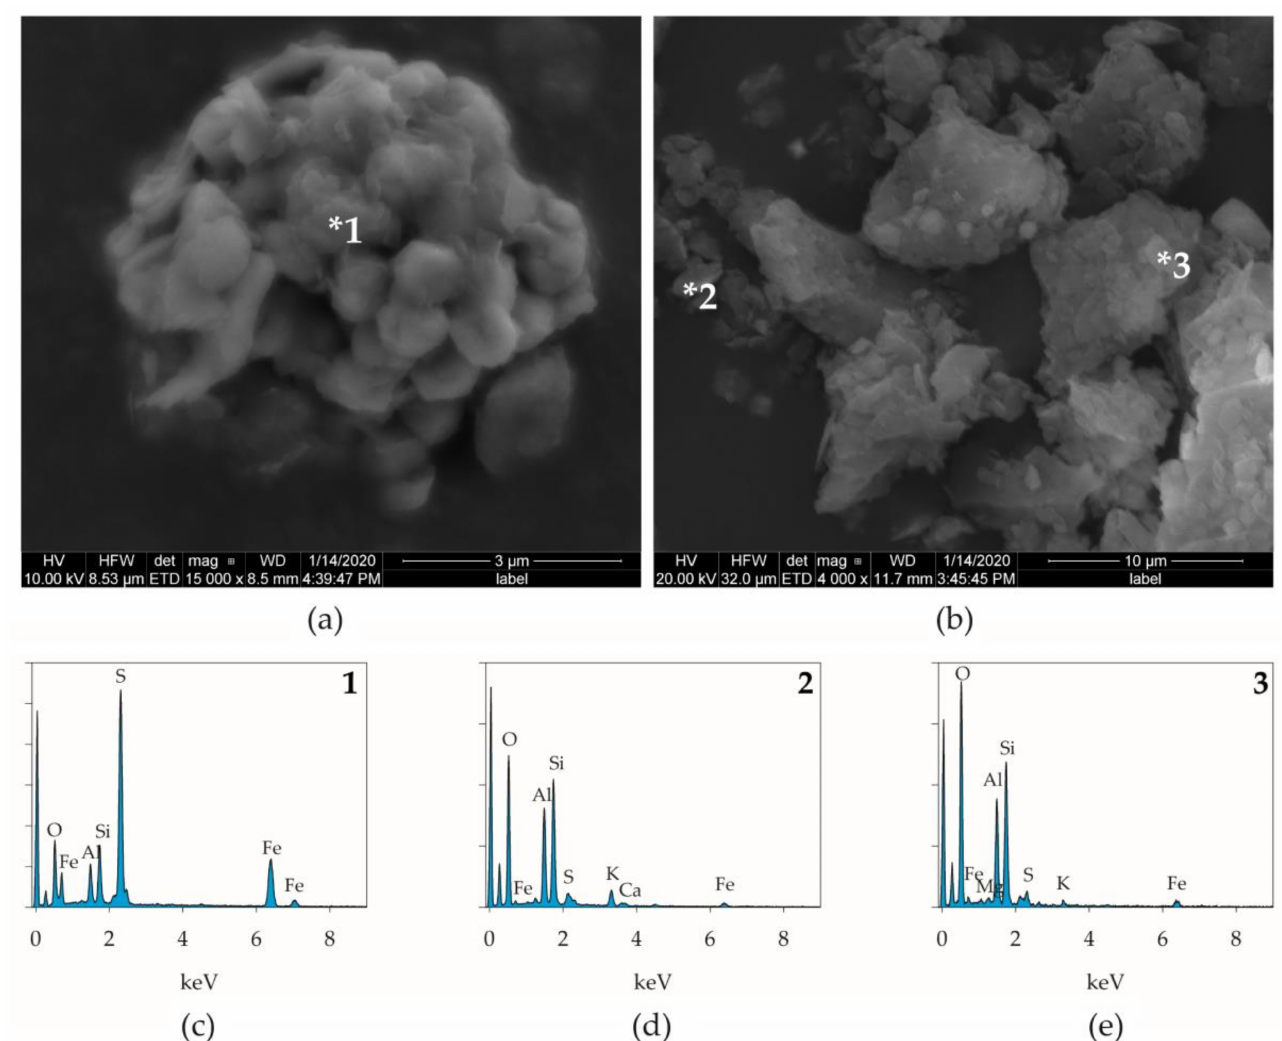
Figure 8. SEM photomicrographs of pyrite and kaolinite in mangrove soils from a mature mangrove (RJ-MM) in Rio de Janeiro ( a , b ) and their corresponding EDS spectra ( c – e ), (* represents the exact surface from where the EDS spectra were obtained). In RJ-MM, the SEM-EDS photomicrographs revealed morphologies of poorly crystalline smooth spherical authigenic pyrite framboids ( a ). In addition, the SEM-EDS photomicrographs showed the presence of irregularly shaped kaolinite particles ( b